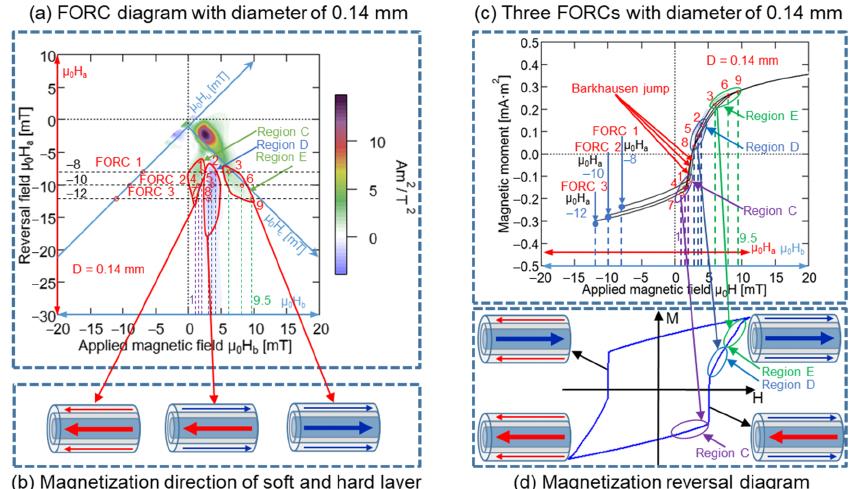
Figure 14. ( a ) FORC diagram of 0.14 mm-diameter Wiegand wire; three FORCs with varying reversal fields, μ 0 H a , of − 8, − 10, and − 12 mT, respectively. ( b ) Magnetization reversal direction of soft and hard layer. ( c ) Three FORCs with 0.14 mm-diameter under reversal fields of − 8, − 10, and − 12 mT. ( d ) Magnetization reversal diagram of minor loop.